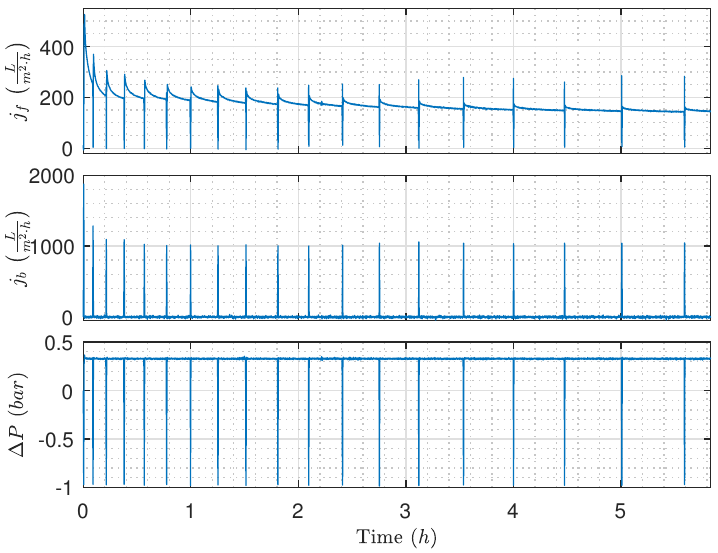
Figure 15. Filtration flux, backwashing flux, and TMP while deploying the proposed algorithm. Experimental conditions: Q cf , ref = 1 m , ∆ P f , ref = 0.33 bar, and ∆ P b , ref = − 1 s